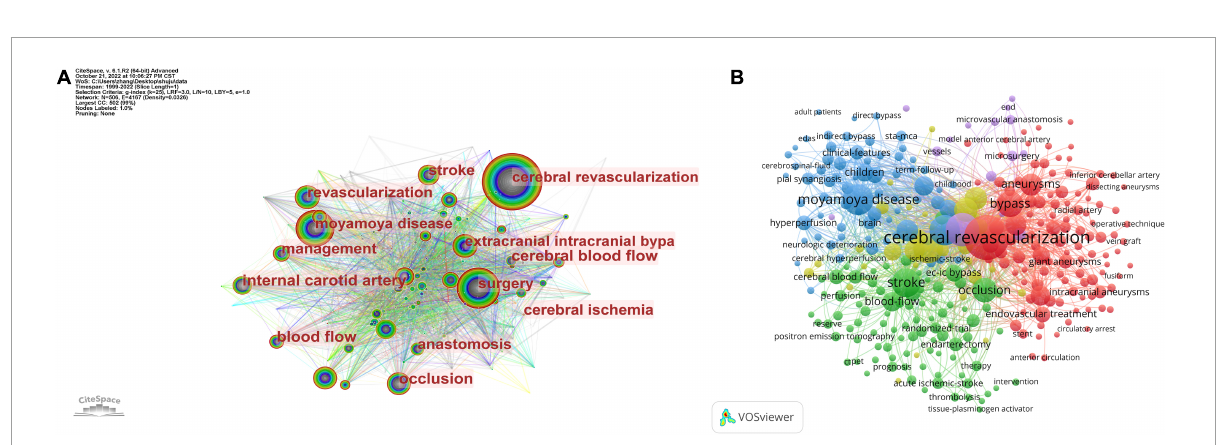
FIGURE7 Keyword analysis. (A) Keyword network map based on Citespace visualization. Each node represents a keyword and each line represents the central cooperation relationship between keywords. (B) Keyword analysis based on the VOSviewer visual map. The clusters of different colors reflect the interrelationship between